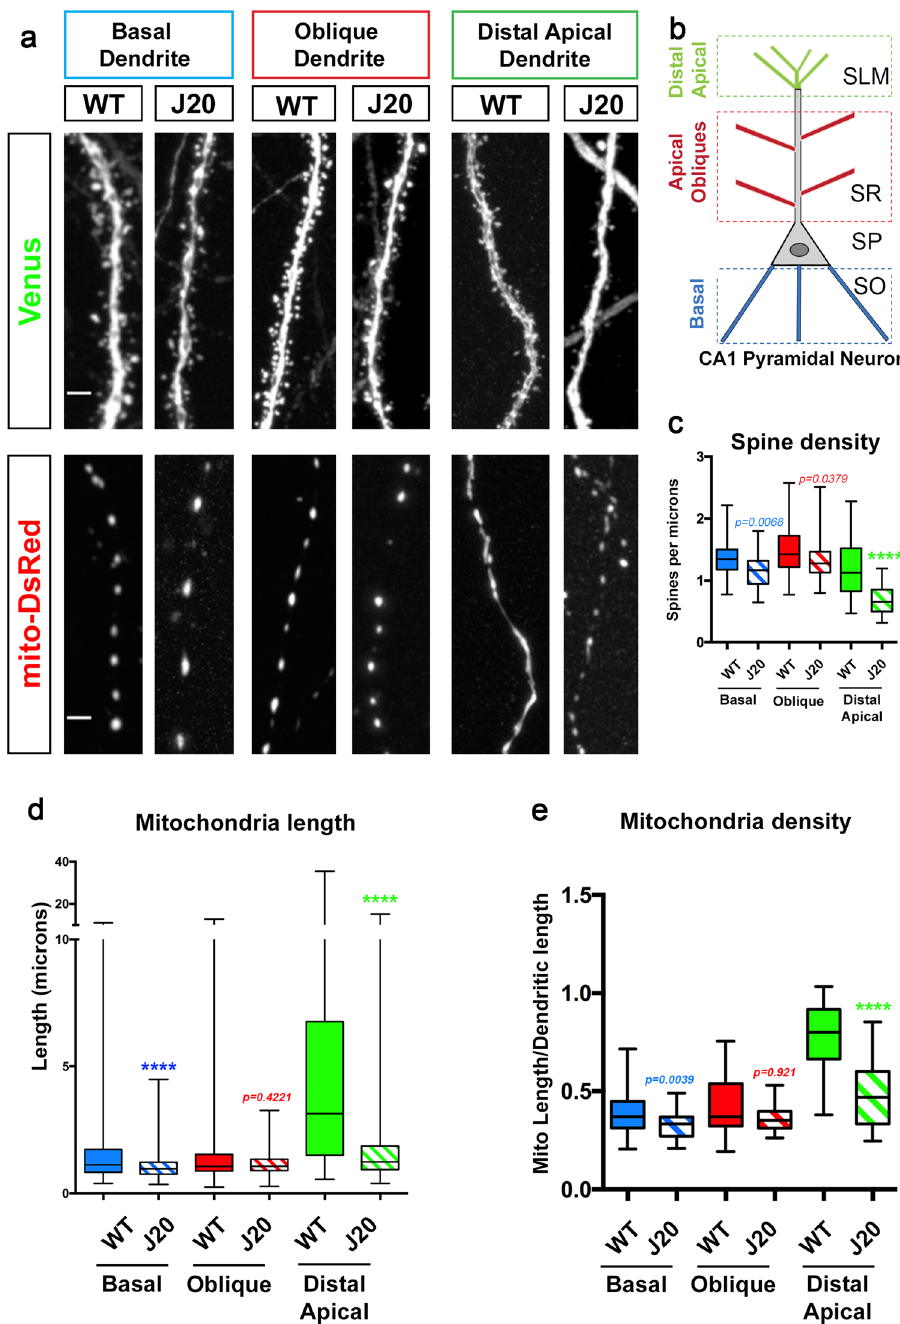
Fig. 1 | In an AD mouse model (J20), CA1 pyramidal neurons display spatially restricted loss of mitochondrial biomass and dendritic spine loss in distal apical tufts. a , b Representative images of CA1 PN dendritic segments from dif- ferent layersofWTcontroland J20mice. CA1PNs wereelectroporated with pCAG- Venus and pCAG-mito-DsRed by in utero electroporation in E15.5 WT and J20 mouse embryos. Bothmouse groupswere fi xed and imagedat3-months postnatal (P90). Dendrites from basal,oblique, and distalapicalare magni fi ed to show spine density and mitochondrial morphology. The three types of dendritic segments were imaged in three distinct layers as depicted in b for both WT and J20 mice. c – e Quanti fi cation of spine density ( c ), individual mitochondrial length ( d ), and mitochondrial density ( e ), measured as the fraction of a dendritic segment length